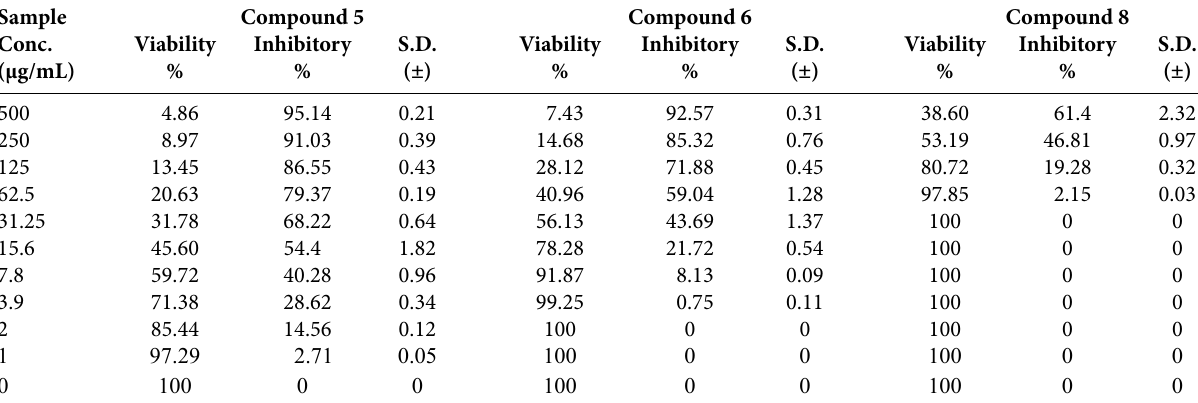
Table 2 . Cytotoxic activity against the HCT-116 of tested compounds Sample Compound 5